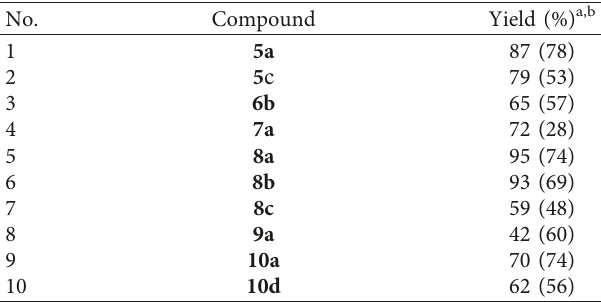
Table 1: Synthesis of the compounds 5 – 10